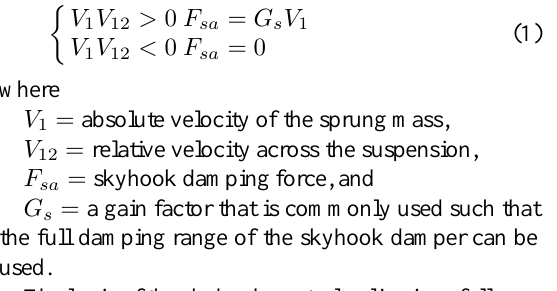
Fig. 2. Schematics of the idealized skyhook